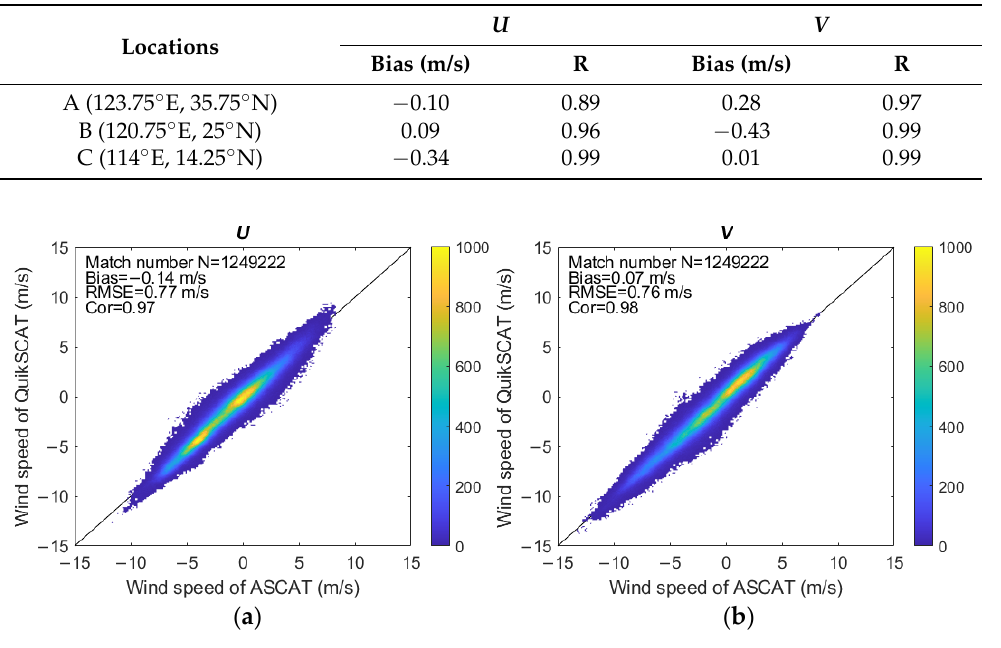
Figure 5. Comparison of QuikSCAT and ASCAT retrieved zonal ( a ) and meridional ( b ) wind speeds in China Seas during the overlapping observation period from January 2007 to November 2009. The colors denote the available match numbers.